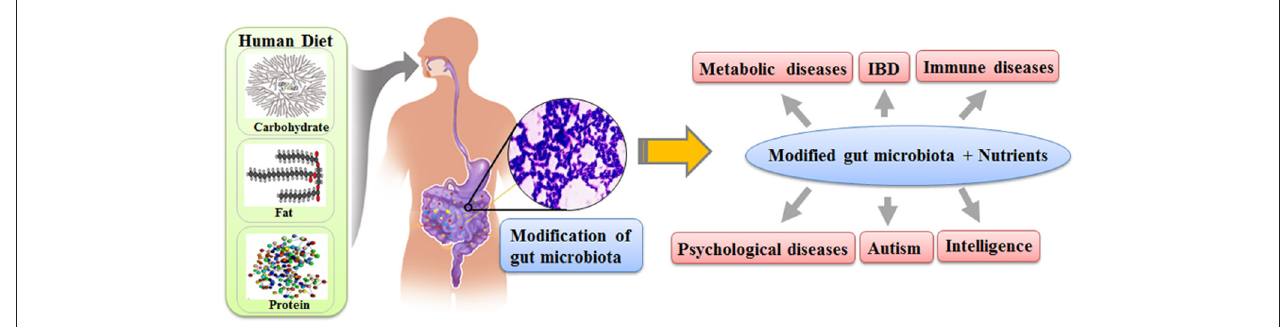
FIGURE 1 | The schematic diagram on how nutrients affect the human traits through gut